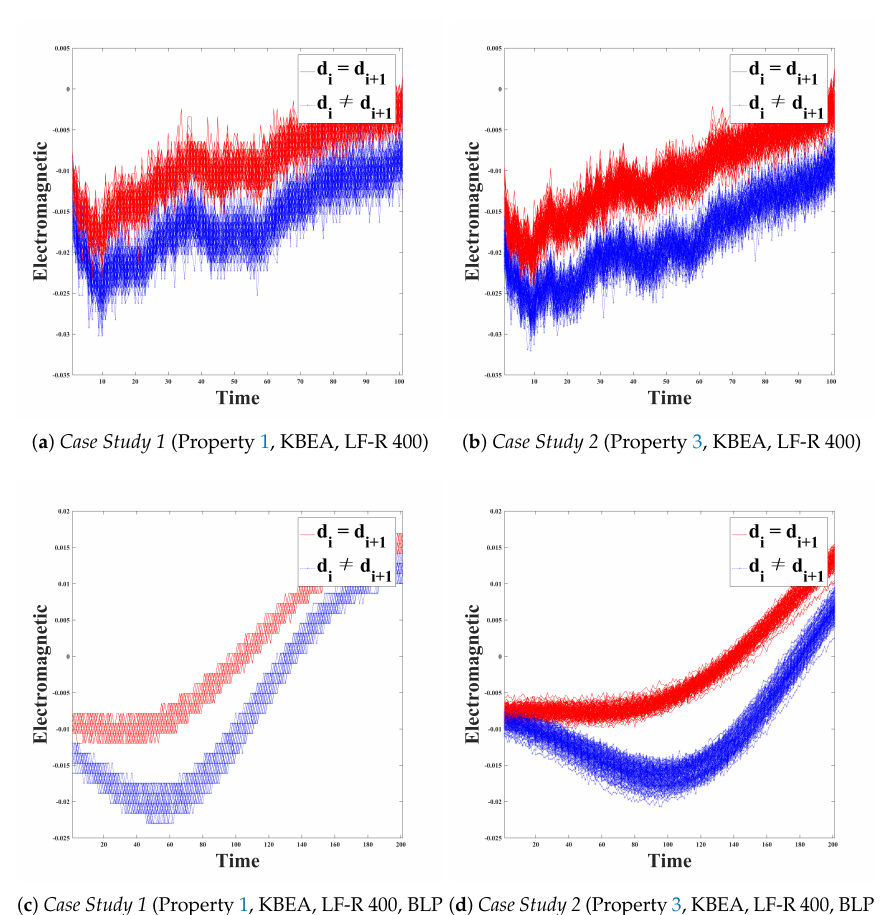
Figure 4. Classification result of PoIs (Hardware Implementation, Electromagnetic). ( a ) Case Study 1 (Property 1, KBEA, LF-R 400); ( b ) Case Study 2 (Property 3, KBEA, LF-R 400); ( c ) Case Study 1 (Property 1, KBEA, LF-R 400, BLP 15-75+); ( d ) Case Study 2 (Property 3, KBEA, LF-R 400, BLP